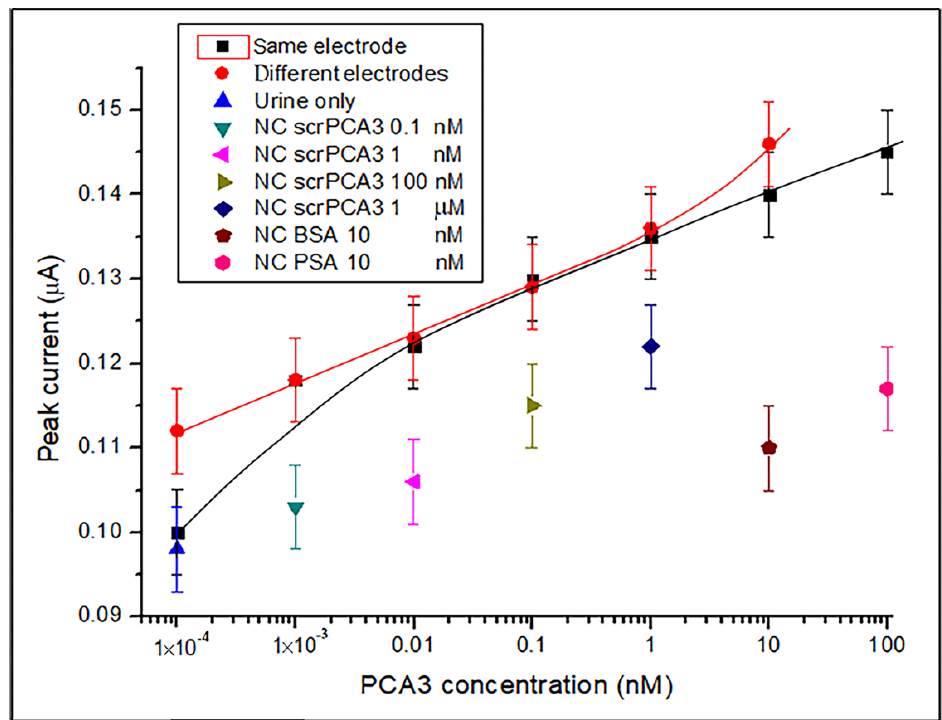
Figure 5. Dependences of the DPV peak current values vs. concentration of PCA3 in synthetic urine: black squares and line correspond to DPV measurements on the same electrode with PCA3 added sequentially; red circles and line correspond to DPV recorded on different electrodes. Individual data points below correspond to negative control tests using scrambled PCA3, BSA, and PSA.